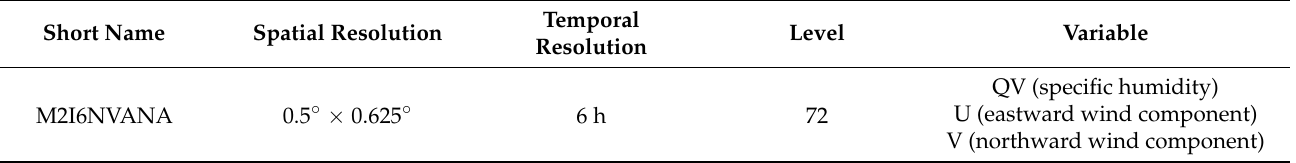
Table 3. Selected meteorological variables in a MERRA2 dataset.